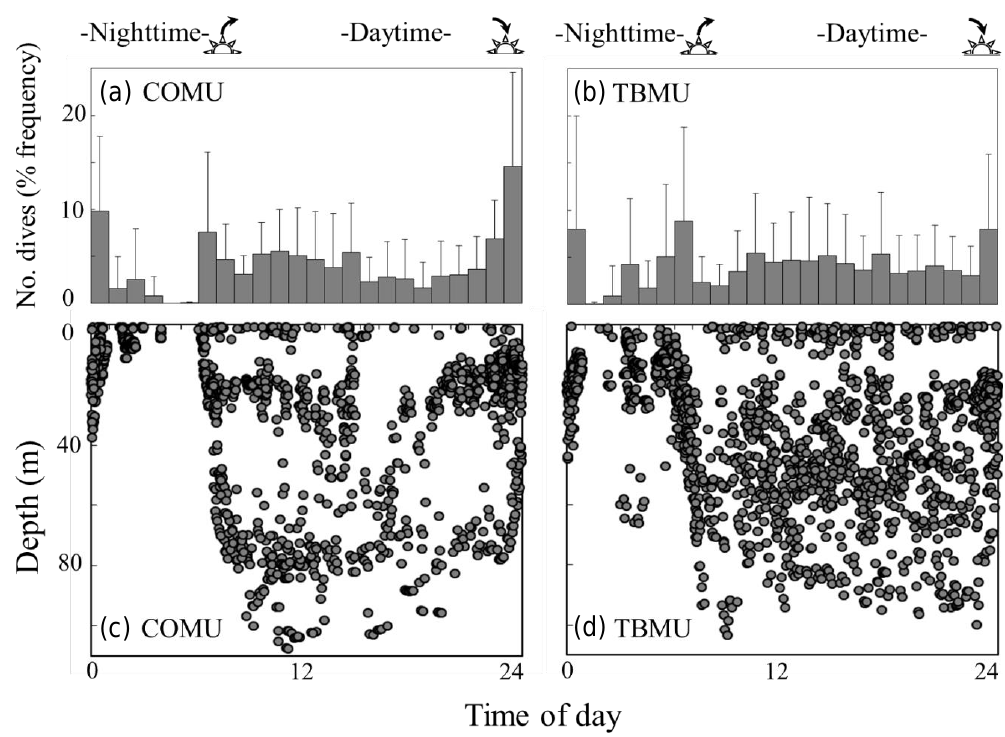
Figure 2. (a, c) Frequency distribution and (b, d) depth distribution pattern of dives in relation to time of day. Left panels represent data for common murres (COMU) and right panels represent data for thick-billed murres (TBMU). Means ± standard deviation (SD) are shown in (b) and (d) , calculated by individual bird data. The timing of sunrise and sunset is shown by marks on the top horizontal axis.